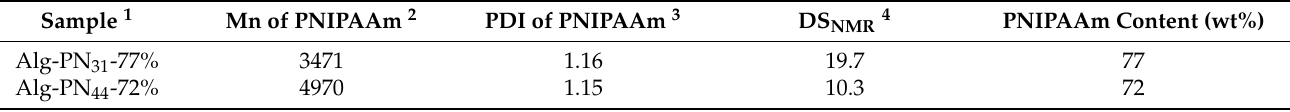
Table 1. List of the alginate- g -PNIPAAm copolymers and their molecular